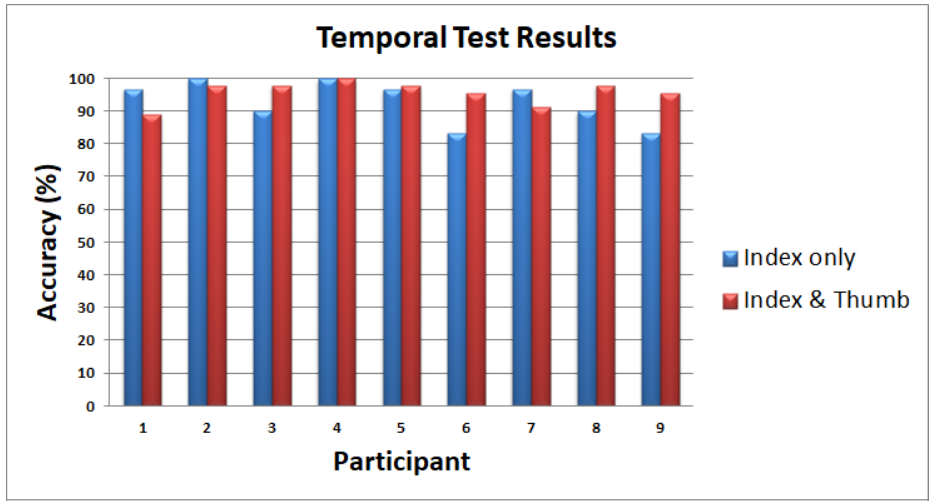
Figure 25. Temporal test results (index